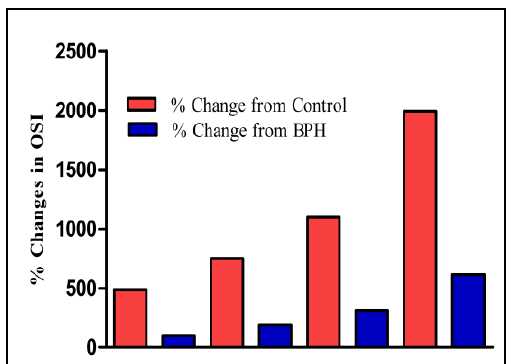
Figure 2: % differences in serum MDA levels in PCa patients with different stages of the disease compared to BPH patients and controls.